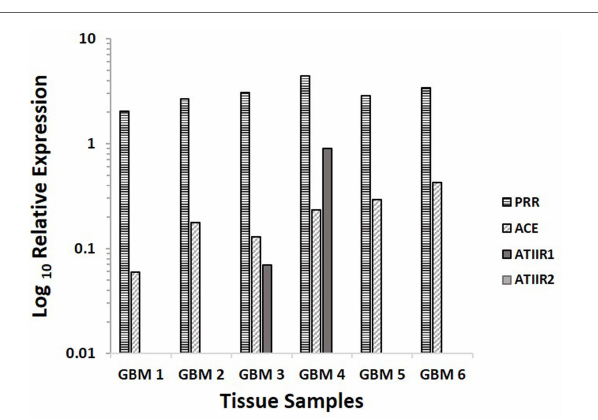
FigUre 4 | relative expression of mrna transcripts of the components of the ras in six gBM samples, depicted as a ratio over the gUsB housekeeper . PRR and ACE were expressed in all six samples. ATIIR1 was present in two and ATIIR2 was below detectable levels out of the six GBM samples examined.